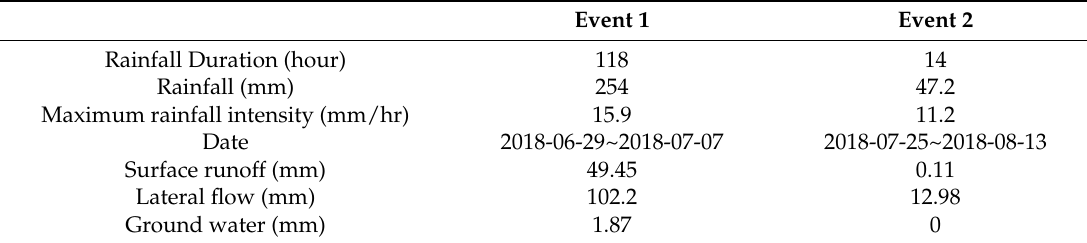
Figure 3. Simulated water flows by soil and water assessment tool (SWAT) model; ( a ) total flow, ( b ) surface runoff, ( c ) lateral flow, and ( d ) ground water. Table 2. Characteristics of rainfall events.